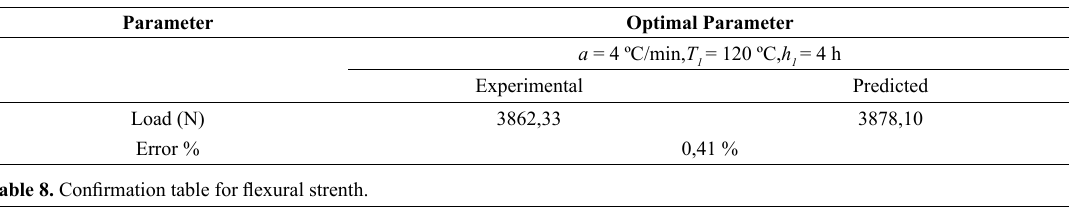
Table 7. Confirmation table for tensile load.